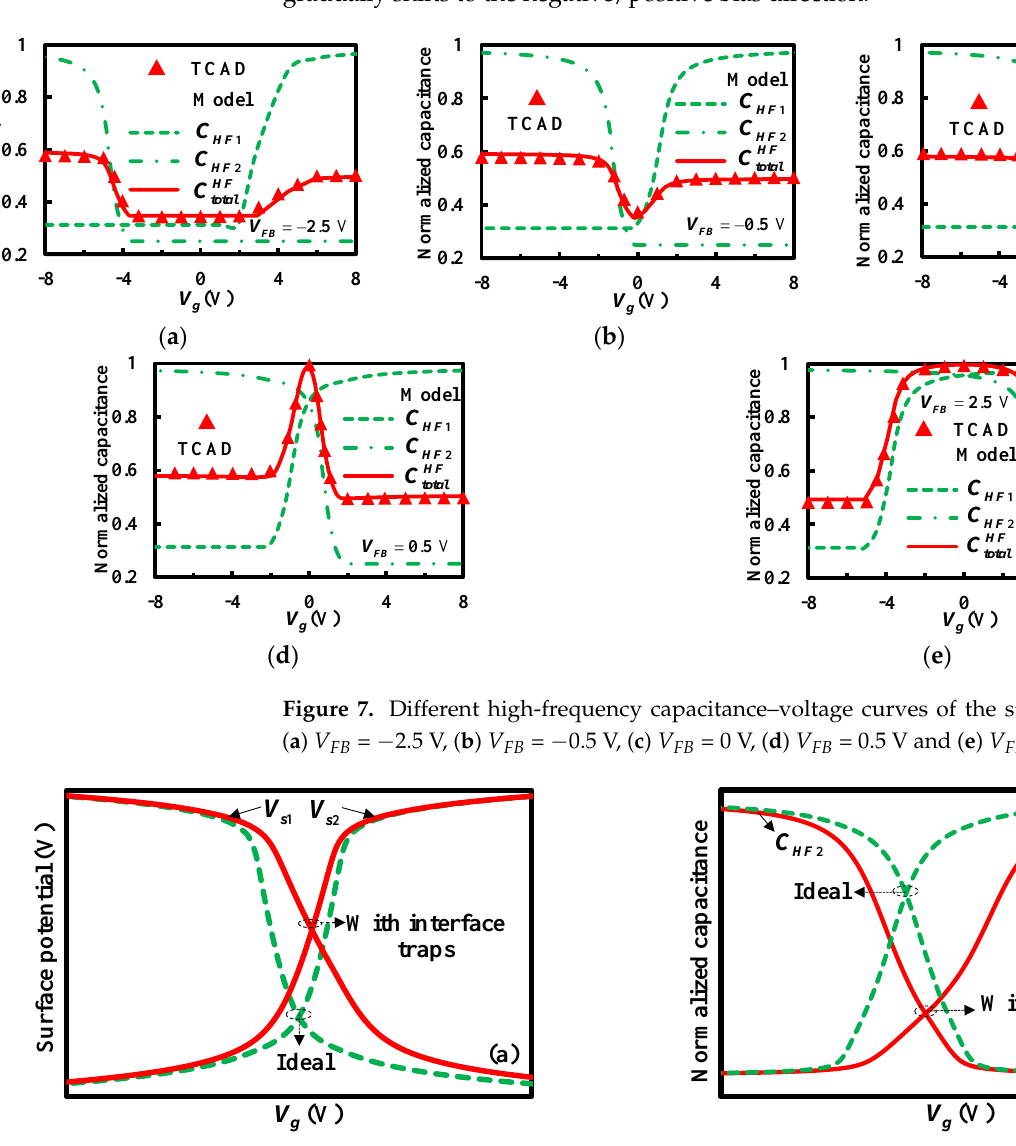
Figure 8. Influence of interface traps on ( a ) surface potentials and ( b ) high-frequency capacitance – voltage curves in the upper and lower MIS structures of the stacked bonding structure. Figure 9 illustrates the analytical and simulated results of the high-frequency capac- itance – voltage characteristics with various interface-trapped charge densities D it 1 and D it 2 . The thickness of the insulator layer is 0.2 μm , and the doping concentrations of the upper and lower silicon layers are 9 × 10 14 cm −3 and 1.5 × 10 14 cm − 3 . The fixed charge density in the insulator layer is 10 10 cm −2 . The work function of the metal φ m is set to 4.65 eV. The tendency of the analytical results coincides well with the simulated results. As shown in Figure 9, the high-frequency capacitance – voltage curves saturate when the positive or